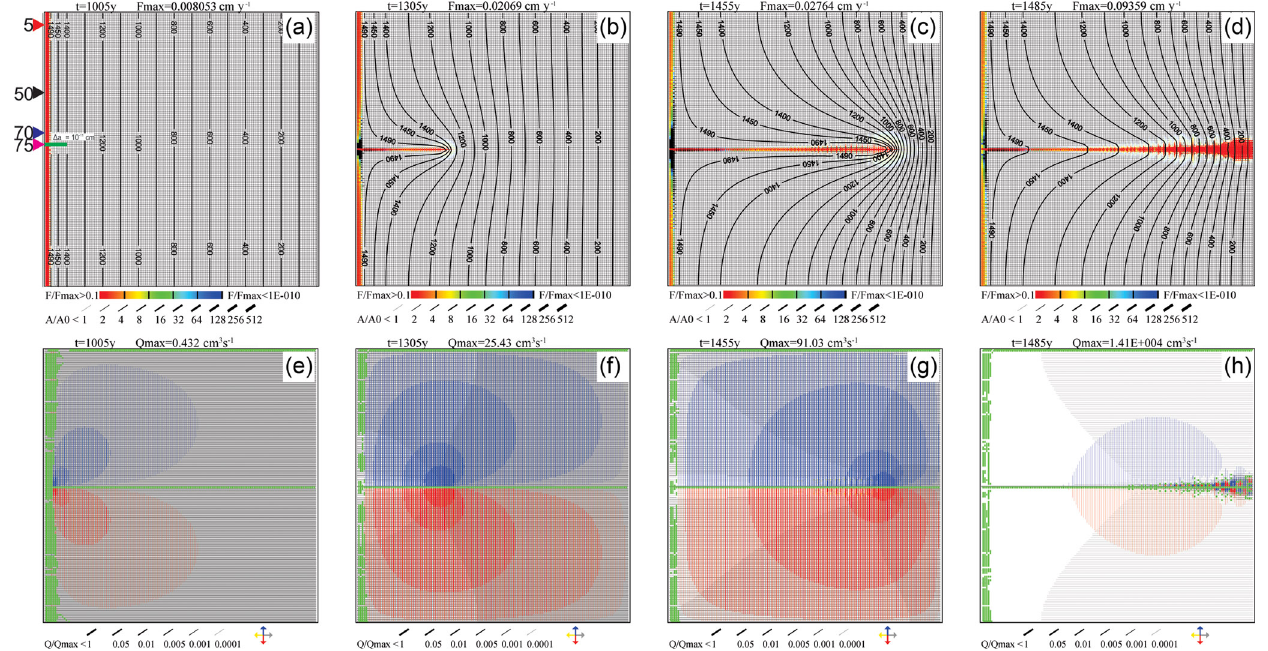
Figure 5. Evolution of a seeded network. Same as Fig. 3 but slightly larger initial apertures by (cid:49)a = 10–11cm are assigned to the first 10 fractures at position 75, denoted by green in (a) .